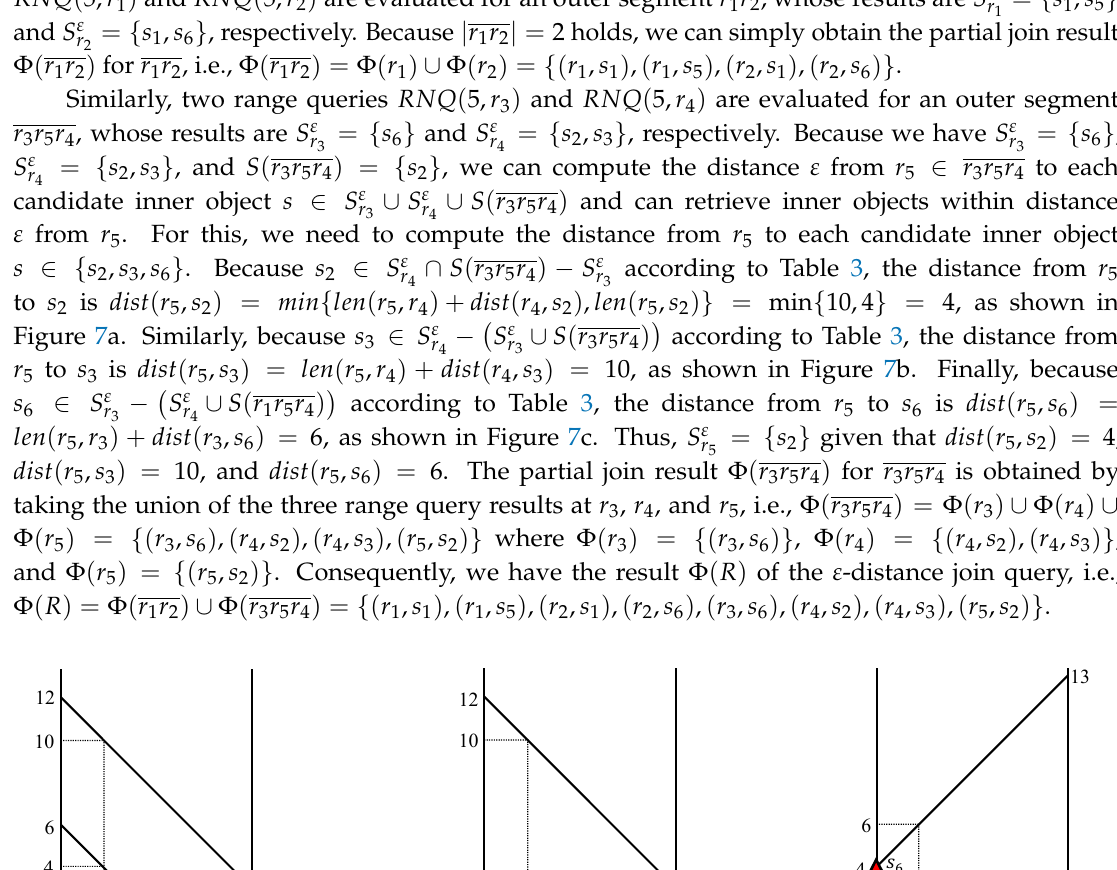
Figure 7a. Similarly, because s 3 ∈ S ε